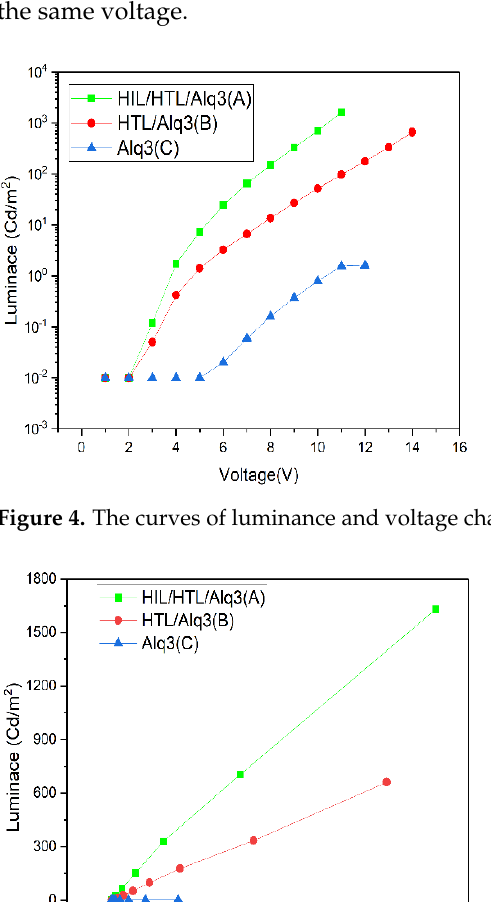
6 of 10 Figure 3. The curves of current density and voltage characteristics with linear – linear scale.